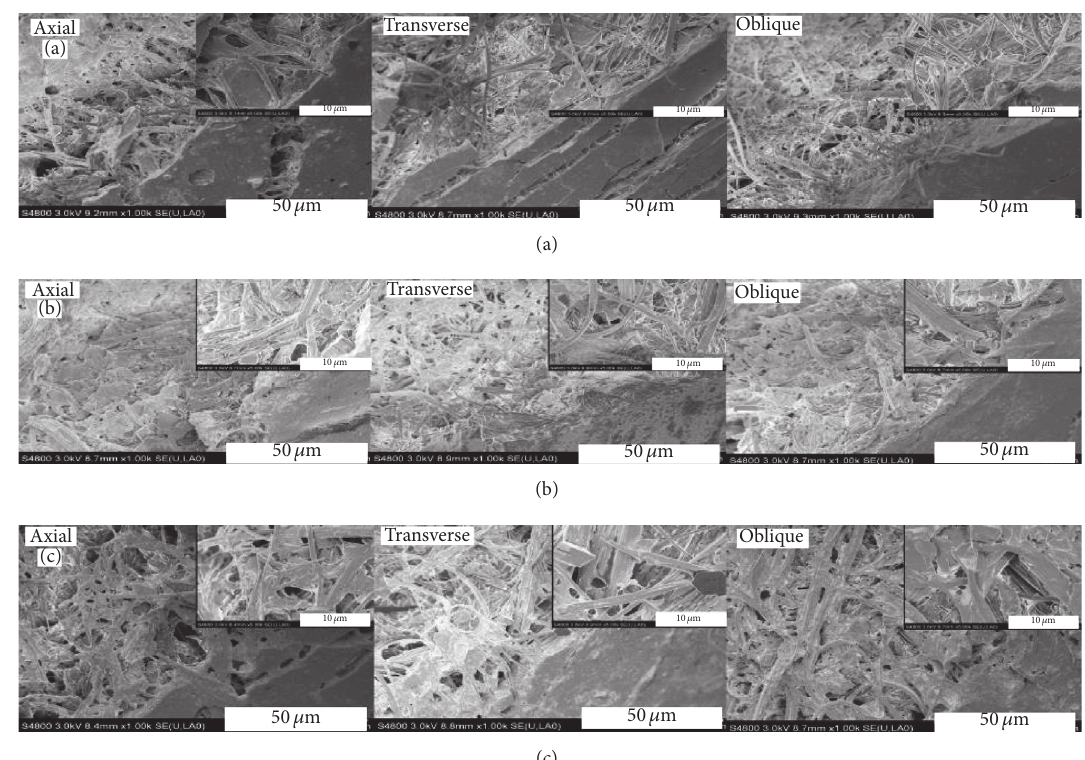
Figure 3: SEM images of the broken sections of the nanocomposites after the tensile test: the interlayer angles of (a) 0 ∘ , (b) 45 ∘ , and (c) 90 ∘